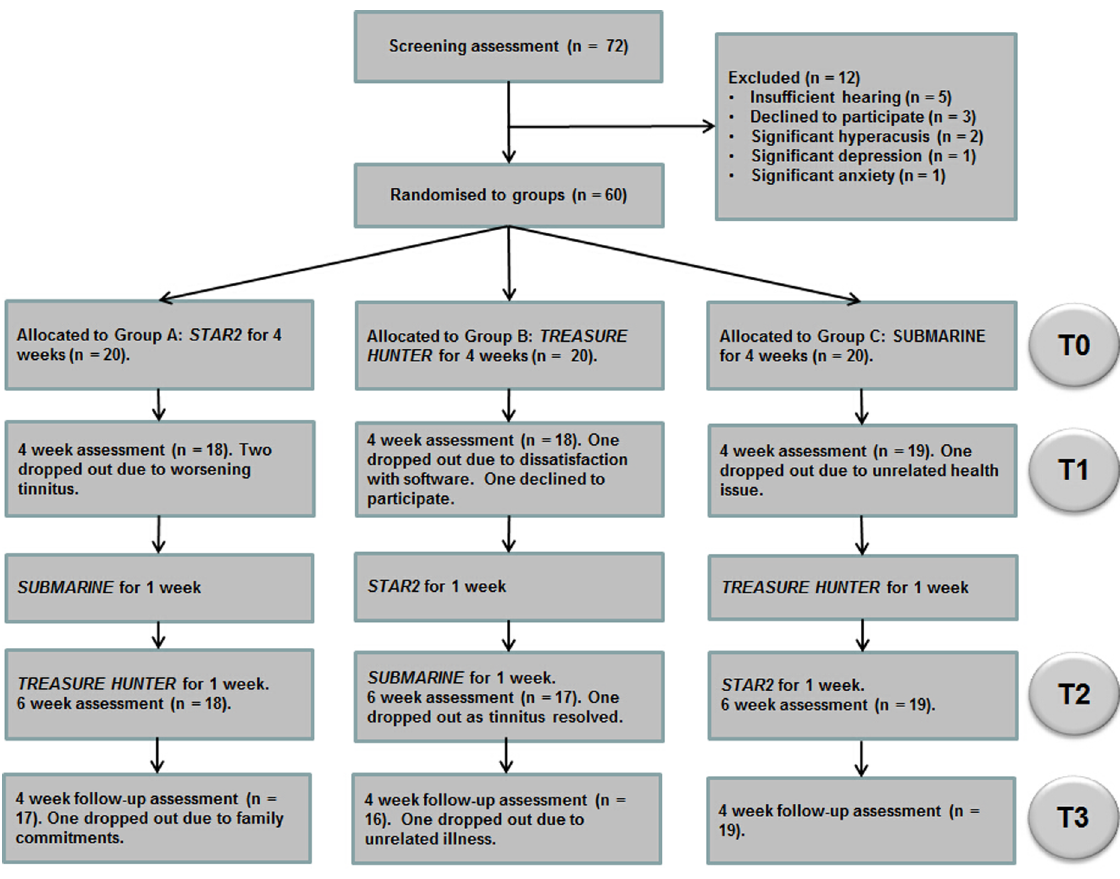
Figure 1. Trial flow chart.